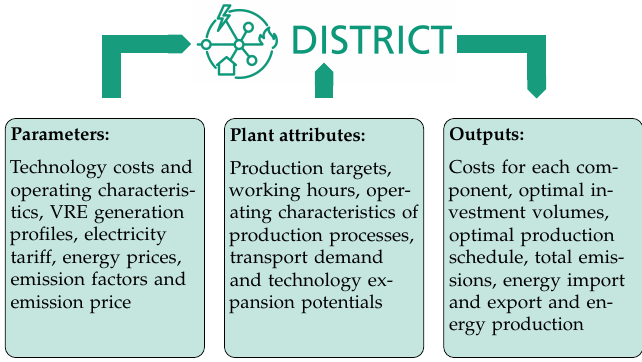
Figure 1. Simplified framework of the